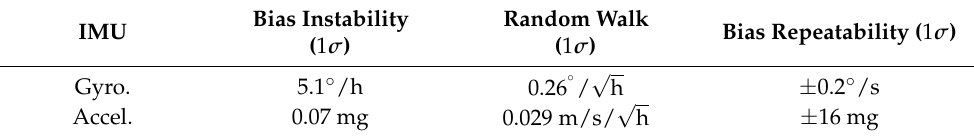
Figure 2. The hardware platform and equipment of the vehicular experiment. Table 3. The specific performance indicator of the